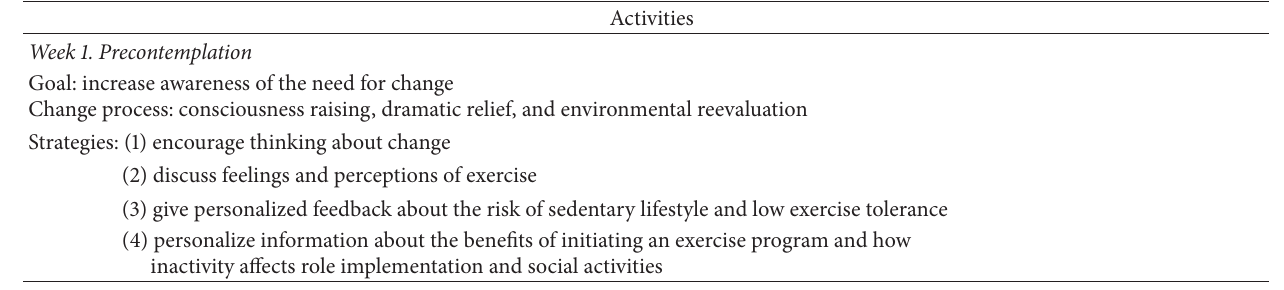
Table 1: The behavioral intervention